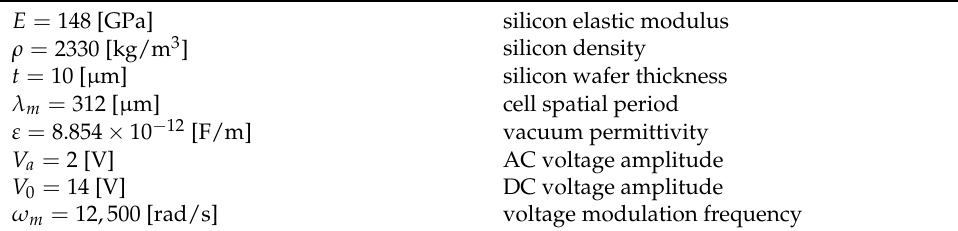
Table 2. Mechanical and electrical parameters.